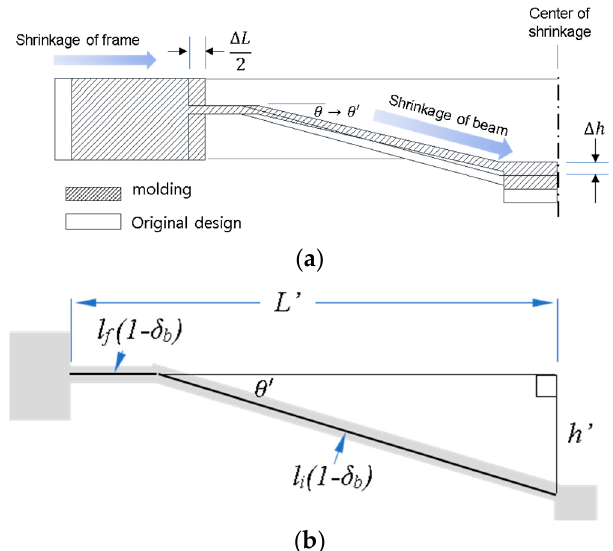
Figure 10. Model of shrinkage for mold compensation: ( a ) shrinkage and change of geometry (half of molded part); ( b ) notations of dimension for shrunk structure. Table 2. Dimensions of mold and molded parts of the original and the compensated mold, whose errors were obtained by comparing original design dimensions.